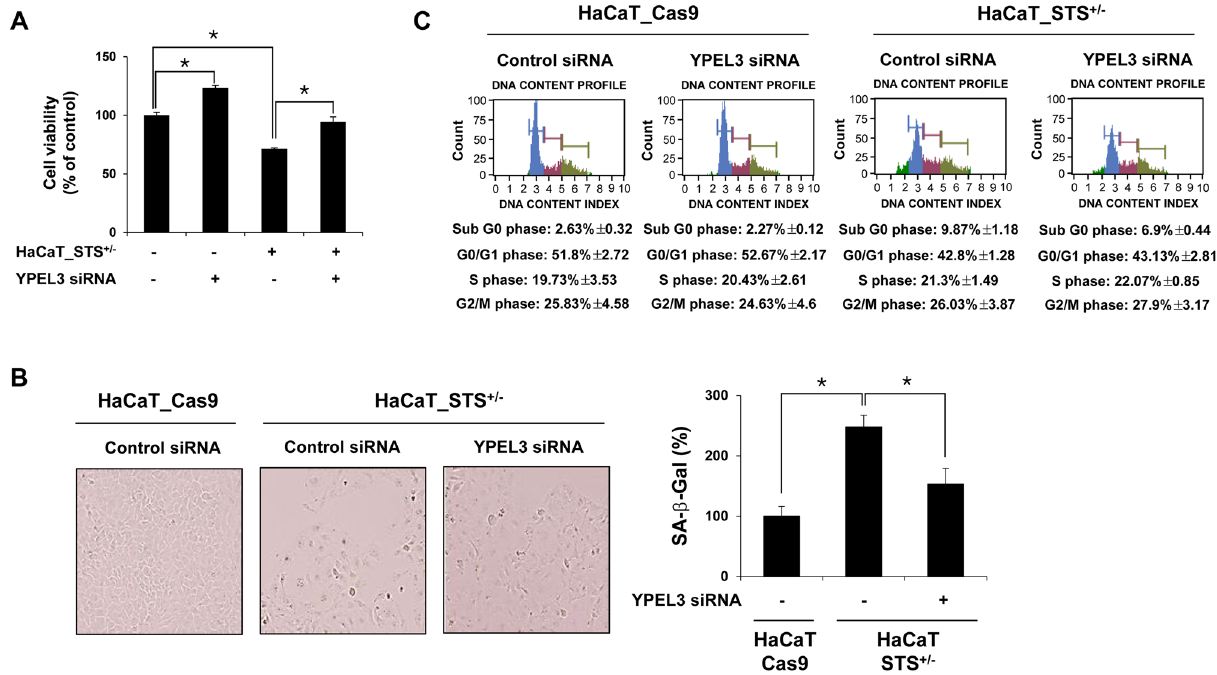
Figure 2. Increased YPEL3 levels by STS deficiency cause cellular senescence. ( A ) HaCaT_Cas9 and HaCaT_ STS +/− cells were transfected with YPEL3 siRNA (50 nM) for 48 h. Cell viability was measured using CCK assay. The data represent the mean ± SD (n = 3). ( B ) HaCaT_STS +/− cells were transfected with YPEL3 siRNA (50 nM) for 48 h. Cellular senescence was measured using CST-senescence β-galactosidase staining kit. The data represent the mean ± SD (n = 3). ( C ) HaCaT_Cas9 and HaCaT_STS +/− cells were transfected with YPEL3 siRNA (50 nM) for 48 h. Cell cycle was measured using Muse cell cycle kit. The data represent the mean ± SD (n = 3). *p <